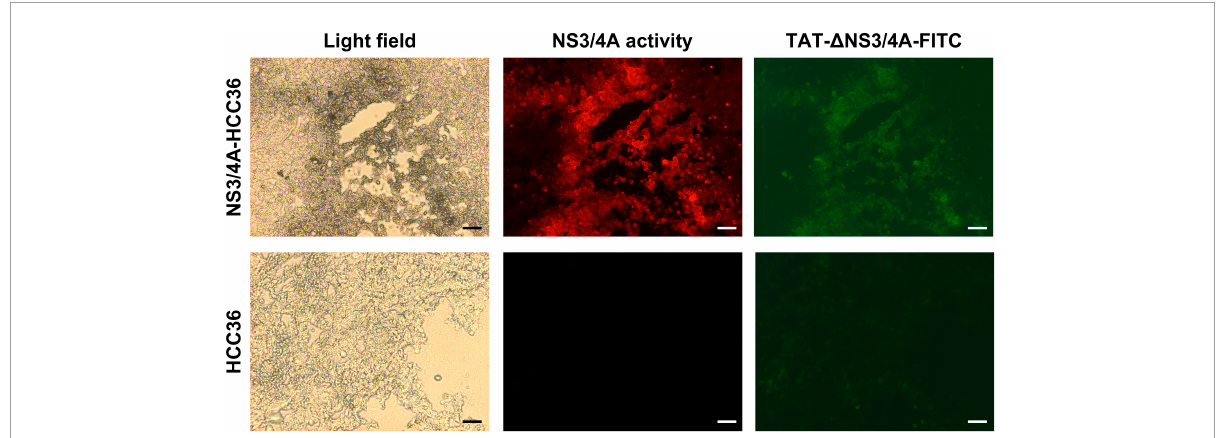
FIGURE3 Specific retention of TAT- (cid:49) NS3/4A-FITC in NS3/4A-expressing tumors in vivo . Mice bearing established NS3/4A-HCC36 and HCC36 tumors were injected with 500 µ M TAT-NS3/4A-FITC and sacrificed after 4 h. Sections of NS3/4A-HCC36 (upper panels) and HCC36 (lower panels) tumors were stained with 520 HCV protease Assay Kit (AnaSpec) to detect NS3/4A activity in tumor sections. FITC-derived fluorescence (green) and NS3/4A activity (red) were observed under a fluorescence microscope. Scale bar: 1 mm.